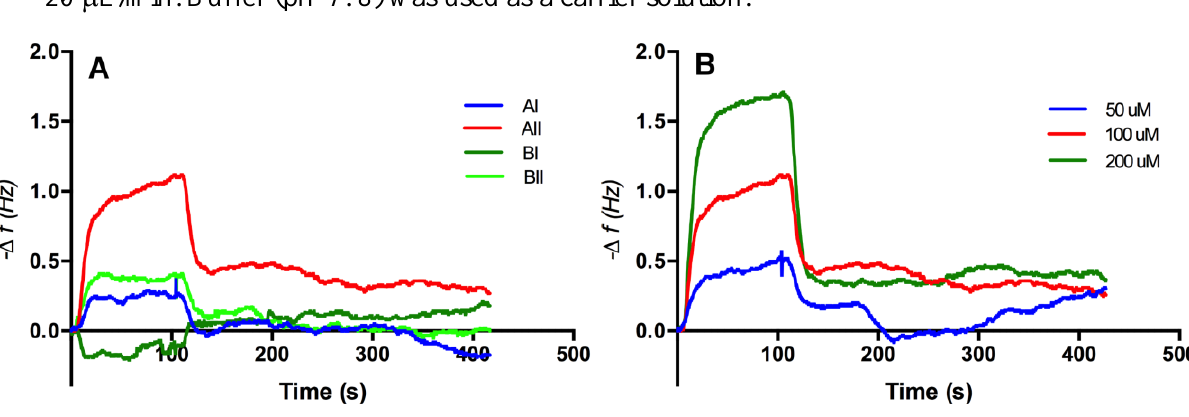
Figure 5. Representative frequency versus time response curves for injections of 100  M of each synthesized peptides ( A ) and peptide AII interaction with the adenine surface in different concentrations ( B ). Volume injected of the peptide was 35  L at a flow rate of 20  L/min. Buffer (pH 7. 8) was used as a carrier